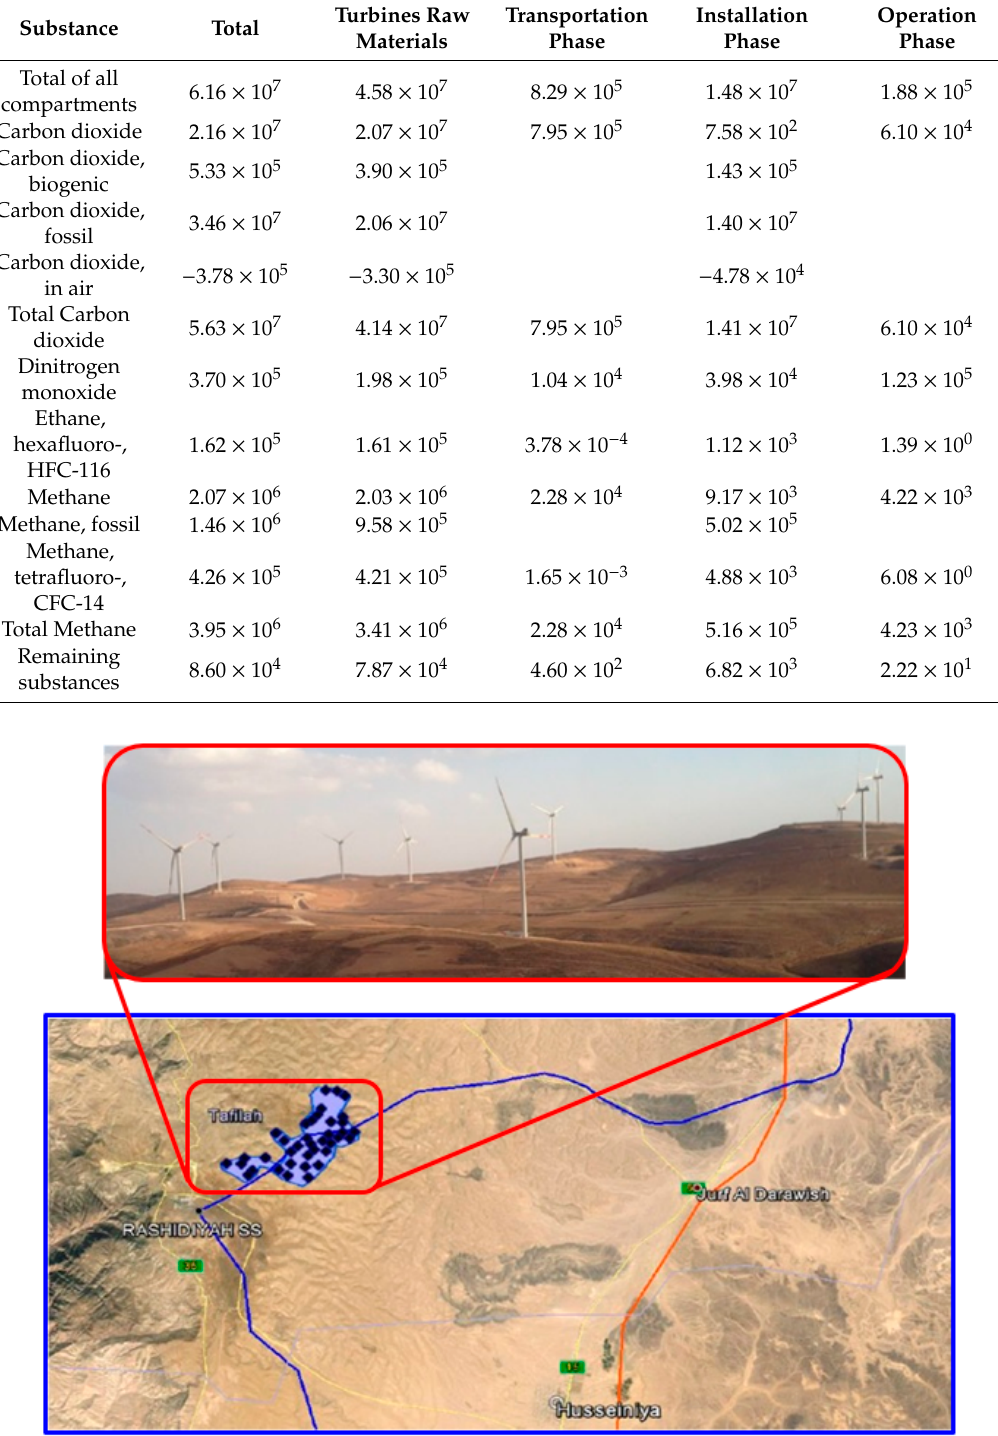
Figure A1. Image of the location of the Tafilah Wind Farm (TWF).